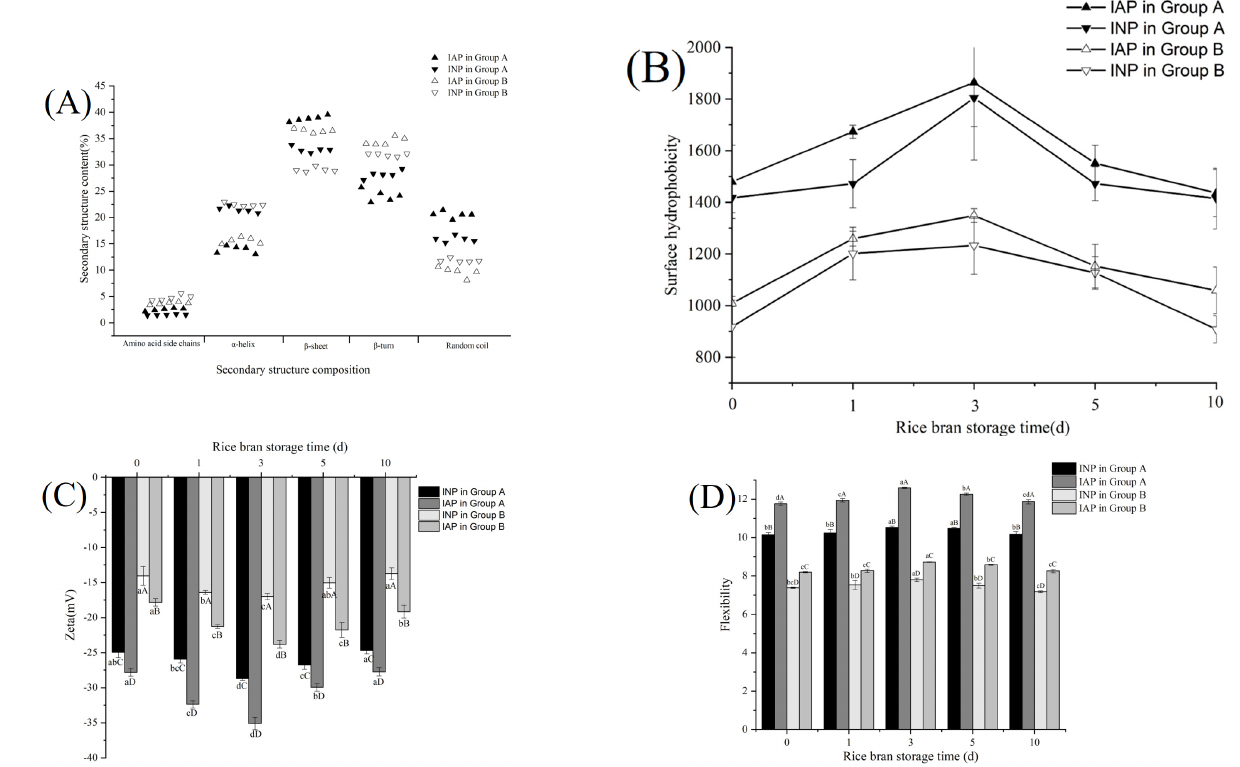
Figure 3. Effects of ultrasonic intensity on the secondary structure ( A ), surface hydrophobicity ( B ), Zeta potential ( C ), and trypsin hydrolysis ( D ) of IAP and INP of RBPE prepared with RB at different storage times, and the different lowercase letters within a column indicate significant differences ( p < 0.05).